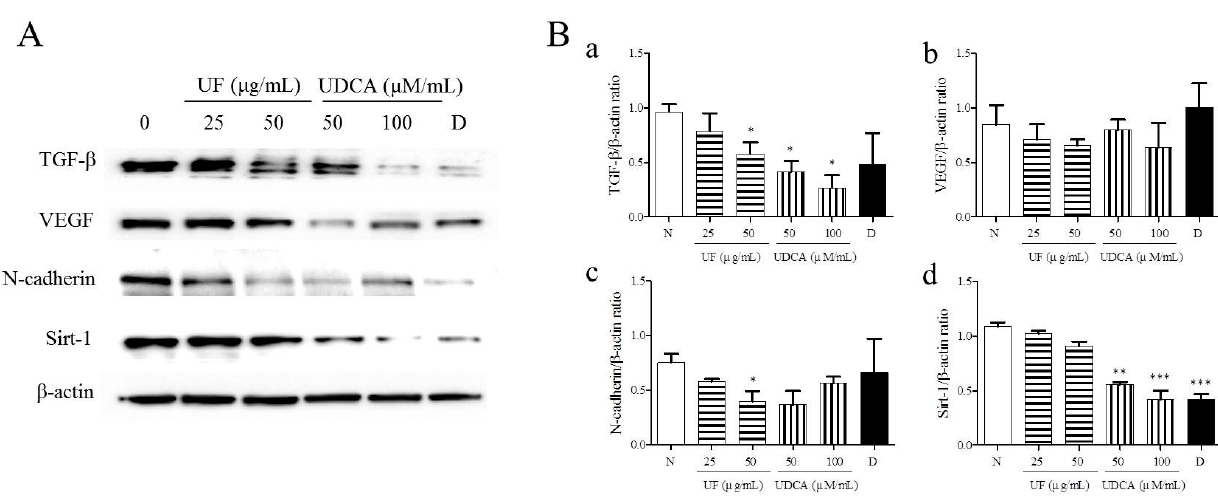
Figure 4. Effects of UF extract and UDCA on the expression of angiogenic proteins in human FRO anaplastic thyroid cancer cells. The cells were treated with UF or UDCA at indicated concentrations for 48 h. The expression of angiogenic proteins TGF- β (a), VEGF (b), N-cadherin (N-Cad) (c), and SIRT-1(d) in the cells was determined by western blotting. ( A ) β -Actin was used as an internal control. The expression of each protein was calculated relative to β -actin expression. Data are representative of three independent experiments. ( B ) * p < 0.05, ** p < 0.01, and *** p < 0.001 vs. normal cells. N, untreated cells; UF25, 25 μ g/mL UF extract treatment; UF50, 50 μ g/mL UF extract treatment; UDCA50, 50 μ M/mL UDCA treatment; UDCA100, 100 μ M/mL UDCA treatment; D, 2 nM/mL docetaxel treatment.